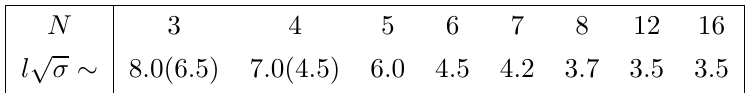
p Table 5 . Approximate values of l (cid:27) for SO( N ) mass spectrum calculations. In brackets the smaller volumes used at low N for the string